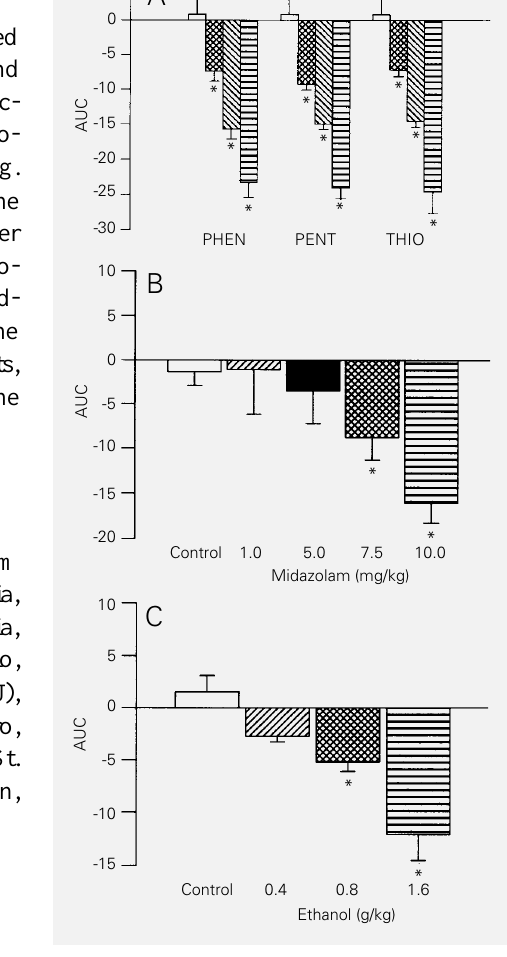
Figure 1 - Dose-response curves for barbiturate- (A), midazolam- (B) and ethanol- (C) induced hy- peralgesia in rats using the tail- flick method. Increasing doses of the barbiturates phenobarbi- tal (PHEN, 5, 20 and 50 mg/kg, ip ), pentobarbital (PENT, 17, 25 and 33 mg/kg, ip ), thiopental (THIO, 7.5, 15 and 30 mg/kg, ip ), midazolam (1-10 mg/kg, ip ) and ethanol (0.4-1.6 g/kg, oral) were administered 10 min before the test. Control animals (open col- umn) received vehicles (propy- lene glycol:saline, 50:50, v/v) ip or oral saline. The results are ex- pressed as mean area under the tail-flick index (TFI) curves (AUC) – SEM for 8 experiments. Hy- peralgesia is represented by negative values on the